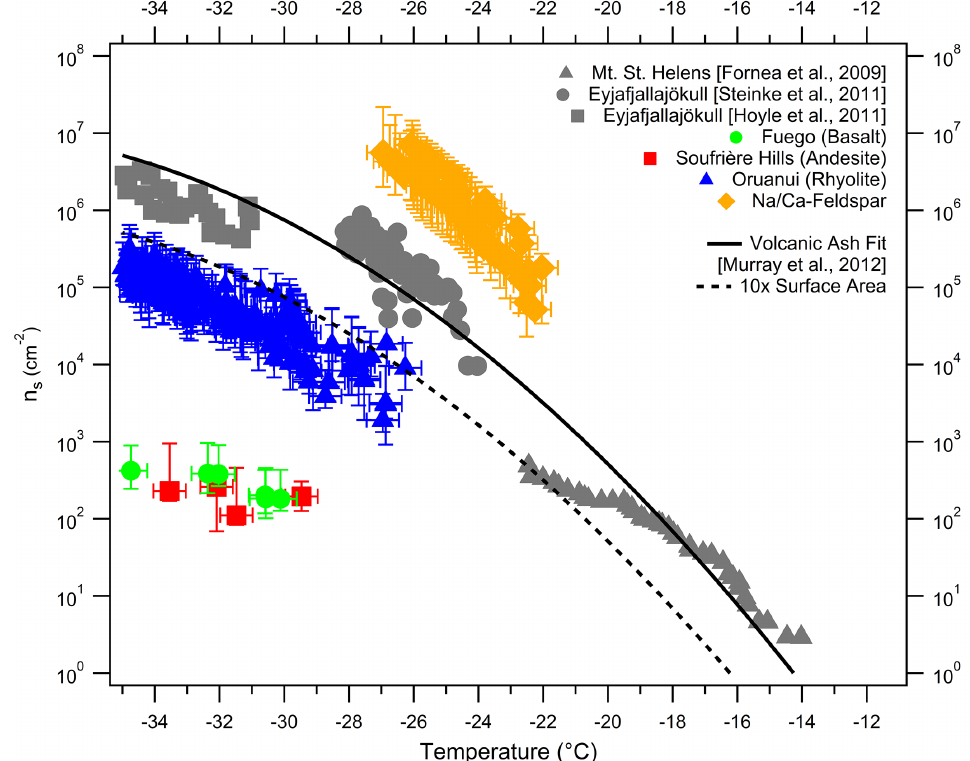
Figure 8. Ice nucleation active surface site densities as a function of temperature for Oruanui, Soufrière Hills, and Fuego ash and NIST SRM-99b soda feldspar. Also shown are n s -values for previous studies (grey markers) on volcanic ash and a parameterization for those data (solid line, Murray et al., 2012). Additionally, a new parameterization has also been shown that assumes surface area of the volcanic to be 10 times greater than the original parameterization to account for the high porosity of volcanic ash (dashed line).